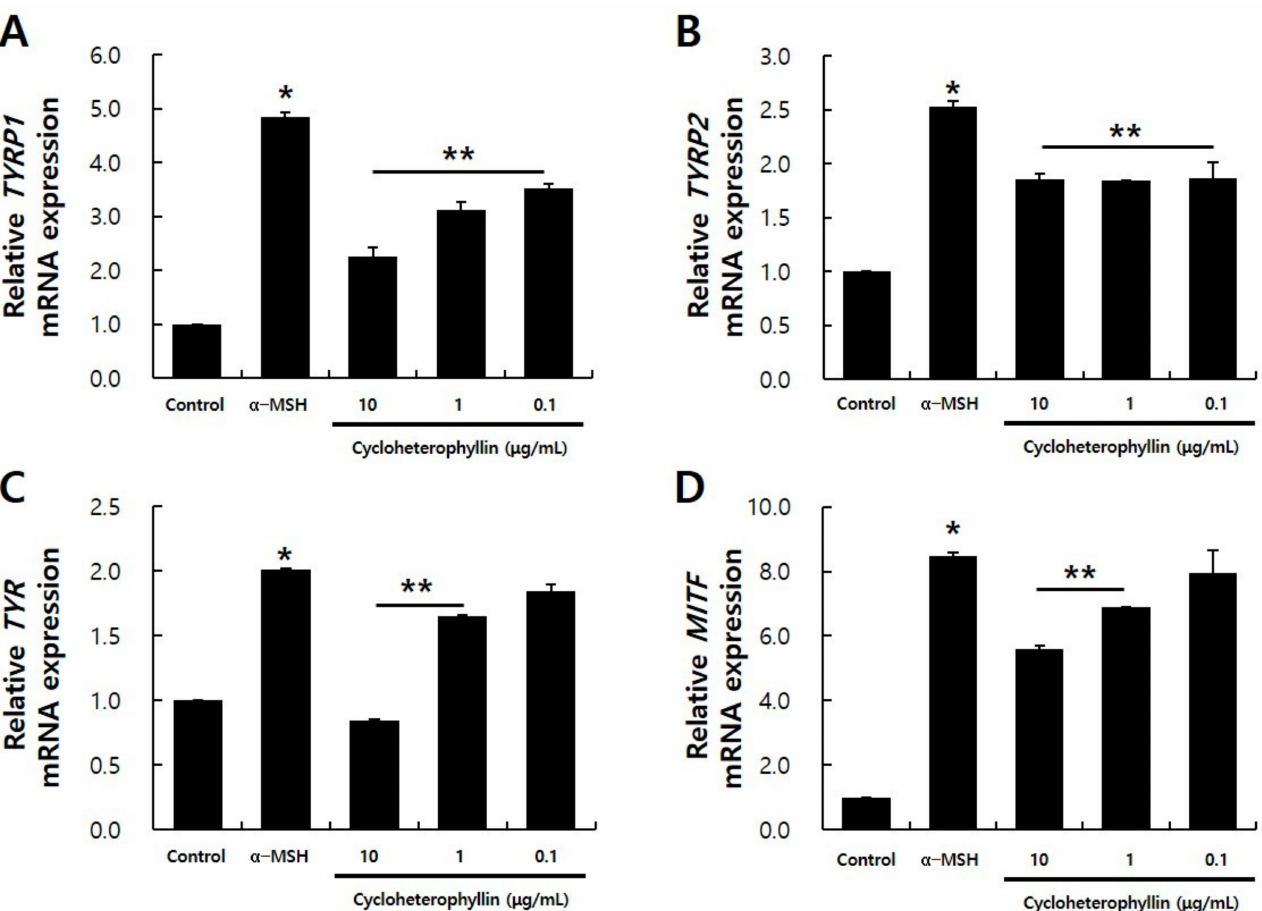
Figure 3. Characterization of cycloheterophyllin treatment on α -MSH-treated B16F10 cells. Real-time RT-PCR analysis of melanocyte markers TYRP1 ( A ), TYRP2 ( B ), TYR ( C ), and MITF ( D ). Values are mean ± S.D. of three independent experiments. * significantly different compared to control, p < 0.05 ** significantly different compared to α -MSH-treated condition, p <